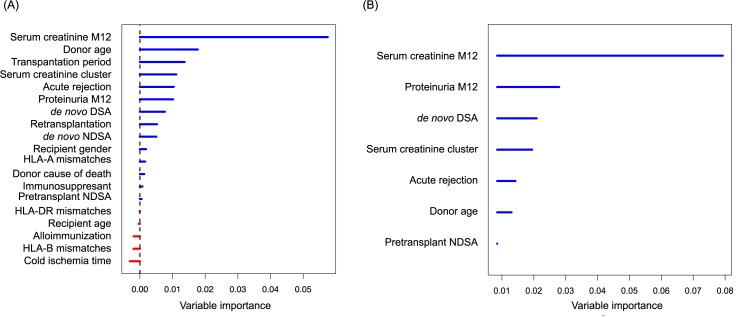
Out-of-bag data variable importance values obtained by random survival forest analysis.(A) full model and (B) final model. The log-rank splitting rule was used.